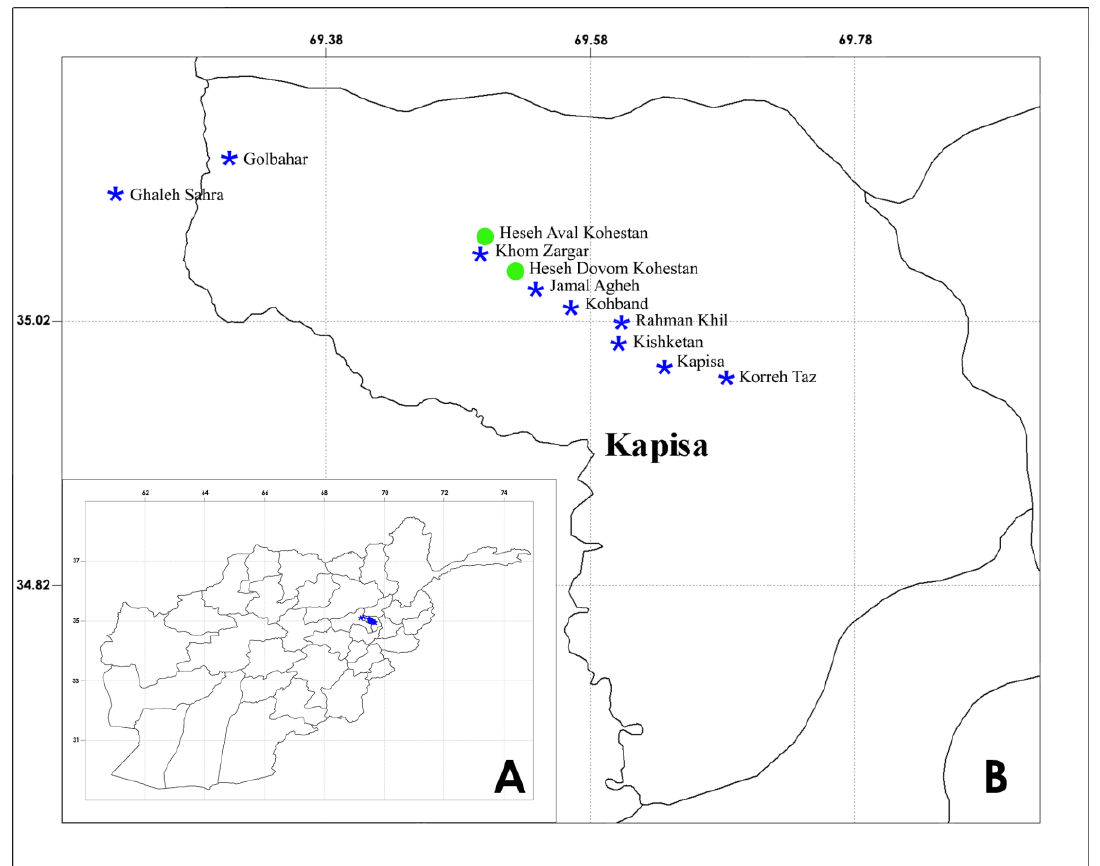
Circles . Woodlands. Blue Stars .